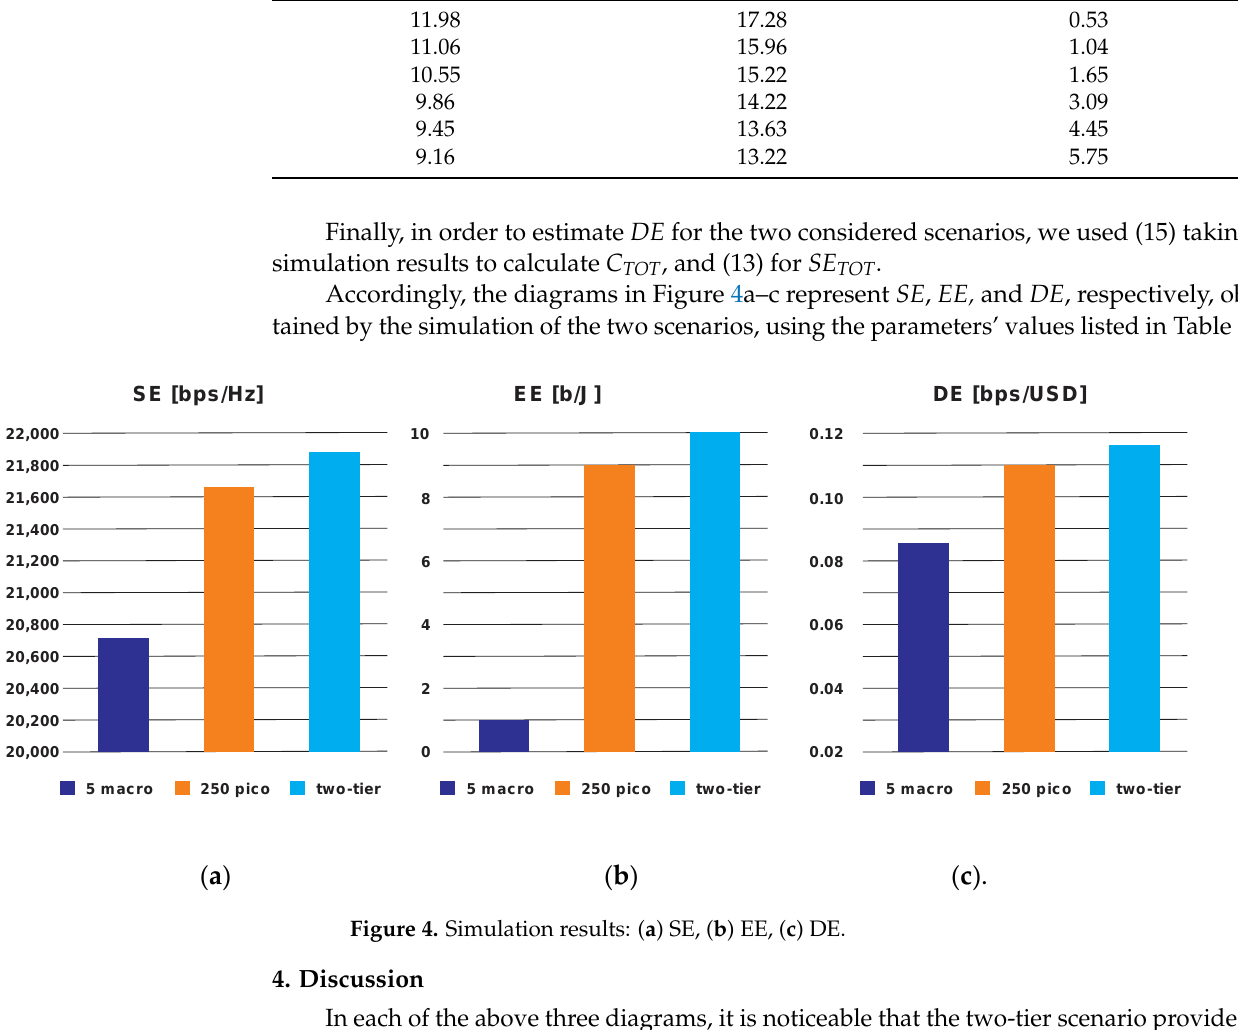
Table 3. Simulation results (after averaging).